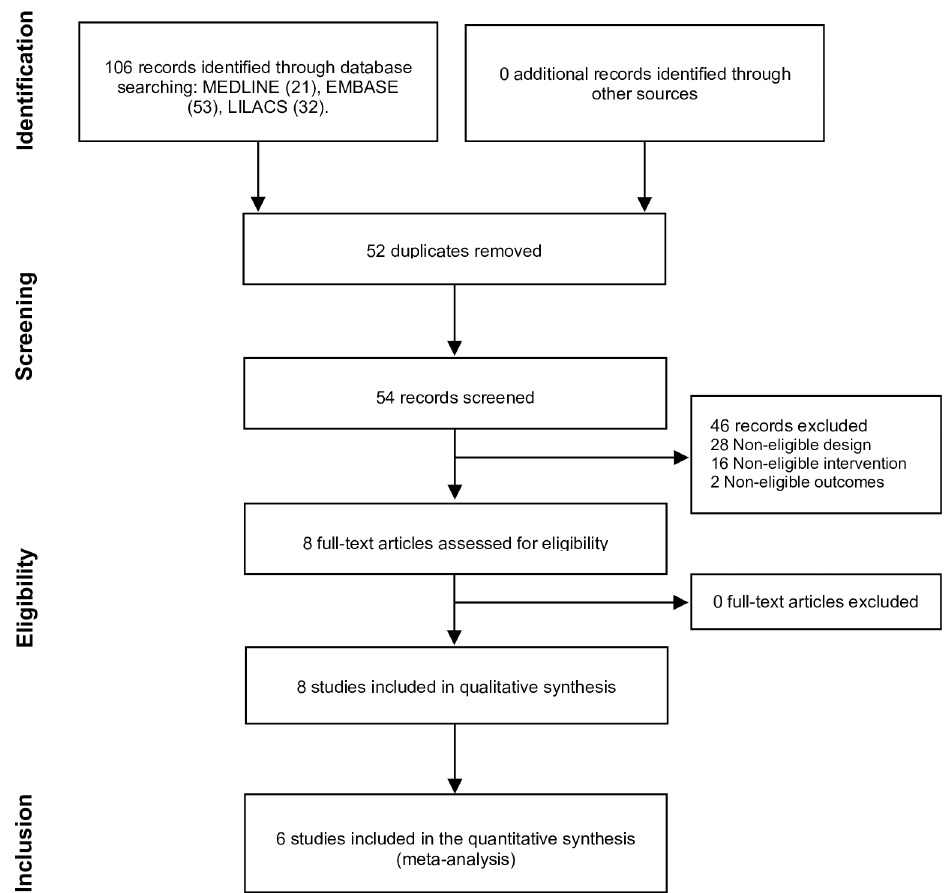
Fig 1. Flowchart of study selection. Six studies evaluated isosorbide, one evaluated nifedipine, and one evaluated both. Four studies had a before-after design, and four were crossover trials.